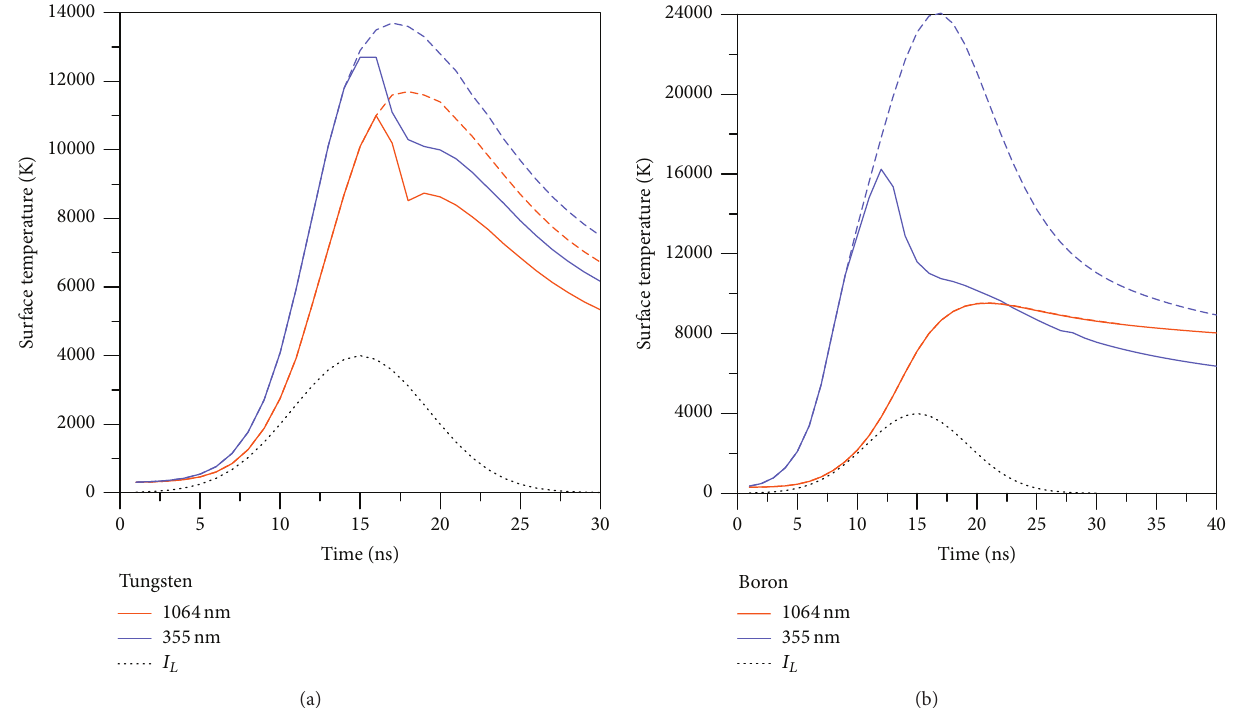
Figure 1: Target surface temperature 𝑇 𝑠 and laser intensity 𝐼 𝐿 during first 40 ns ( 𝑟 = 0 ). (a) Tungsten target and (b) boron target. Broken line denotes case without plasma absorption.